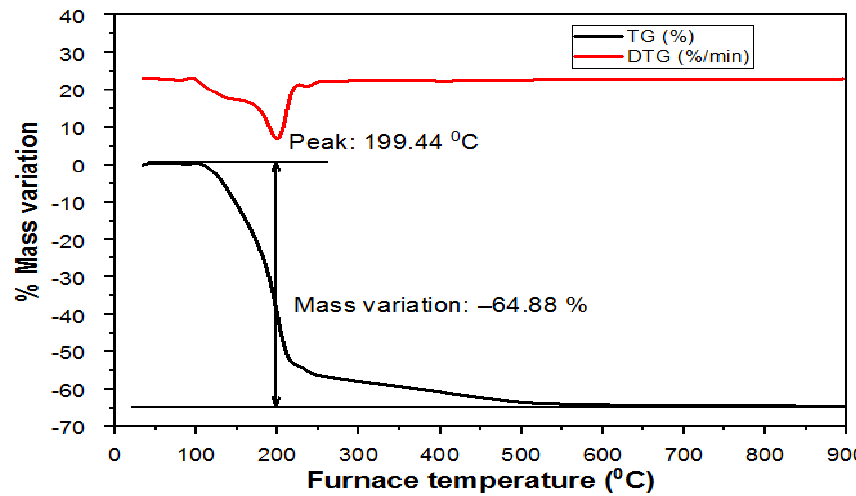
Figure 4. TGA diagram of zirconium compound.